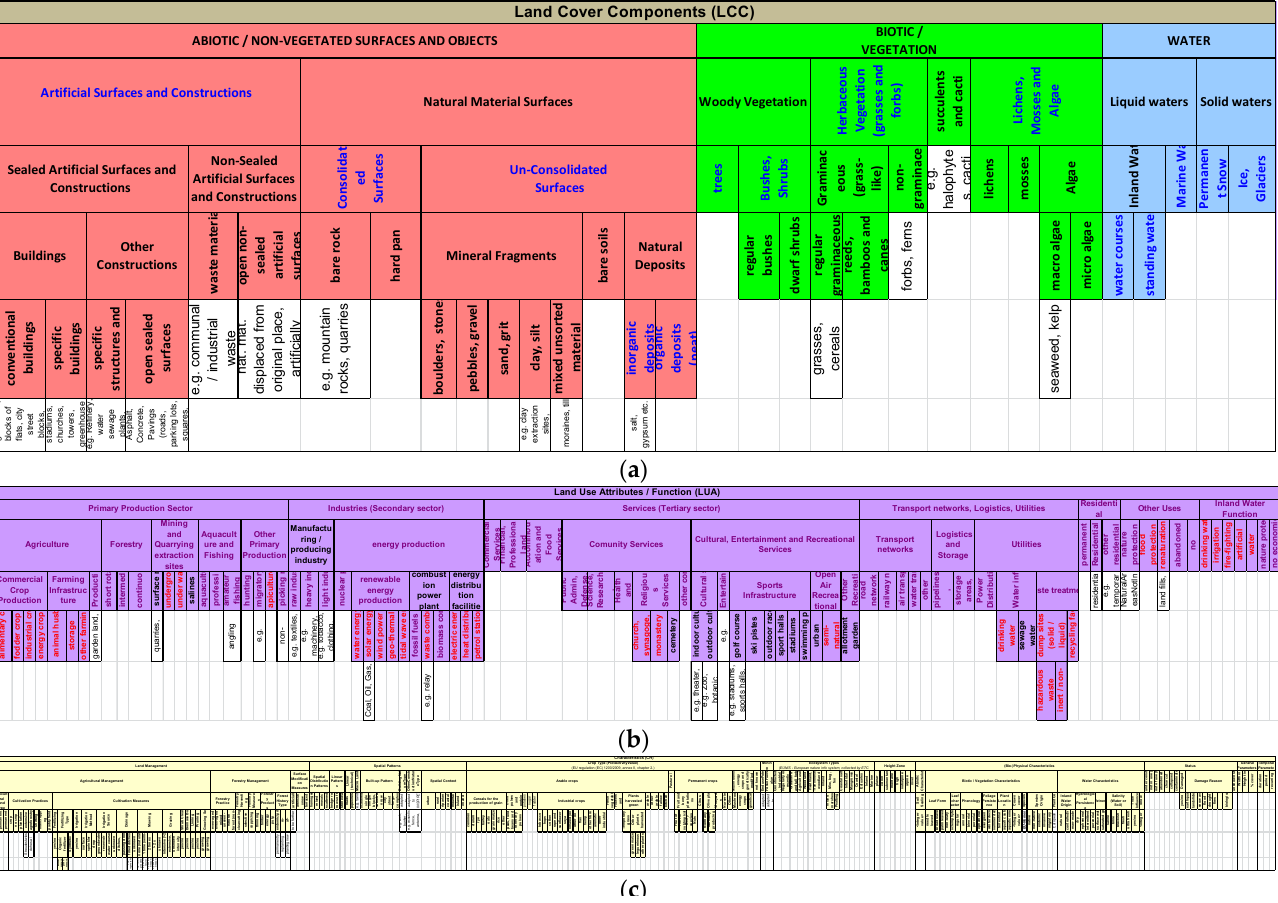
Figure 2. Three parts in the EAGLE Matrix: ( a ) land-cover components (LCCs); ( b ) land-use attributes (LUAs); ( c ) further characteristics (CH).